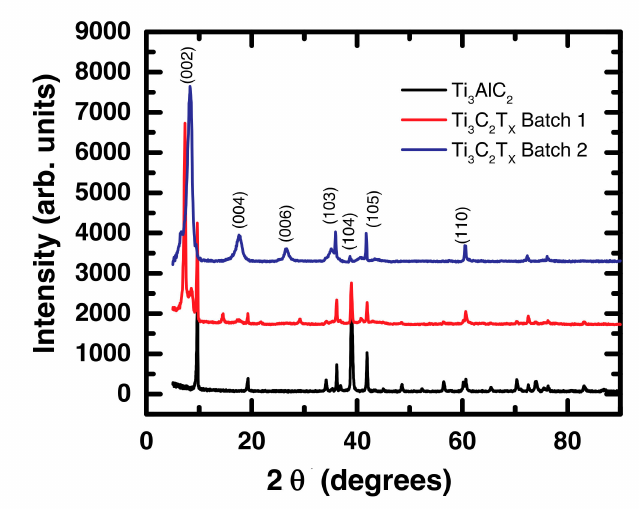
Figure 1. XRD patterns of Ti 3 AlC 2 and Ti 3 C 2 T x MXene samples.